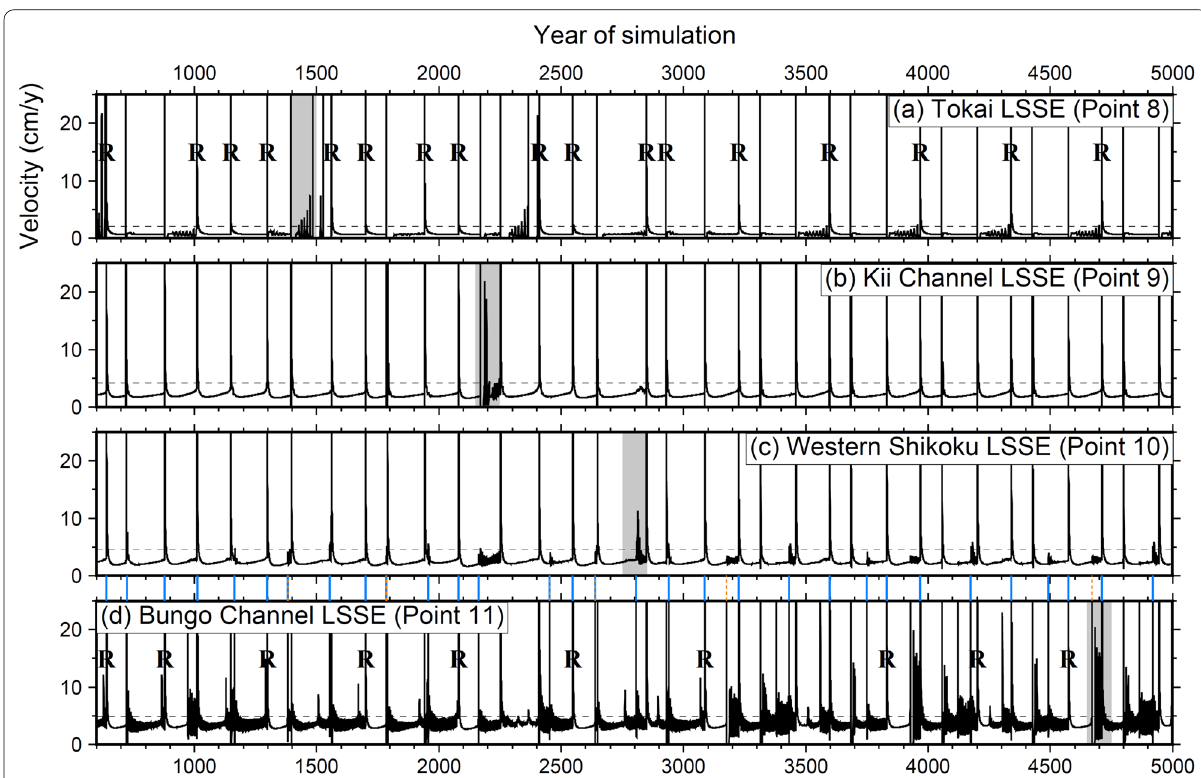
Fig. 11 Time evolution of slip velocity in the a Tokai, b Kii Channel, c western Shikoku, and d Bungo Channel segments (points 8–11 in Fig. 4e, f). Unsaturated low-velocity fluctuations represent LSSEs. Saturated high velocities (> 25 cm/y) represent seismic slips induced by M w 8-class great earthquakes and M w ~ 7.5 Hyuganada earthquakes in the surrounding area, and there are only nine M w 6-class earthquakes with spontaneous seismic slips in the Tokai and Bungo LSSE areas (Additional file 1: Fig. S2). Dashed lines indicate the plate convergence rate at each point. Labels R (for rupture) in a and d indicate great earthquakes in the seismogenic zone up-dip from the LSSE areas. Blue and orange dashed lines between c and d indicate M w ~ 7.5 earthquakes in area Z and M w 6-class earthquakes in the Bungo LSSE area, respectively. Detailed data for the shaded time periods are presented in Fig.